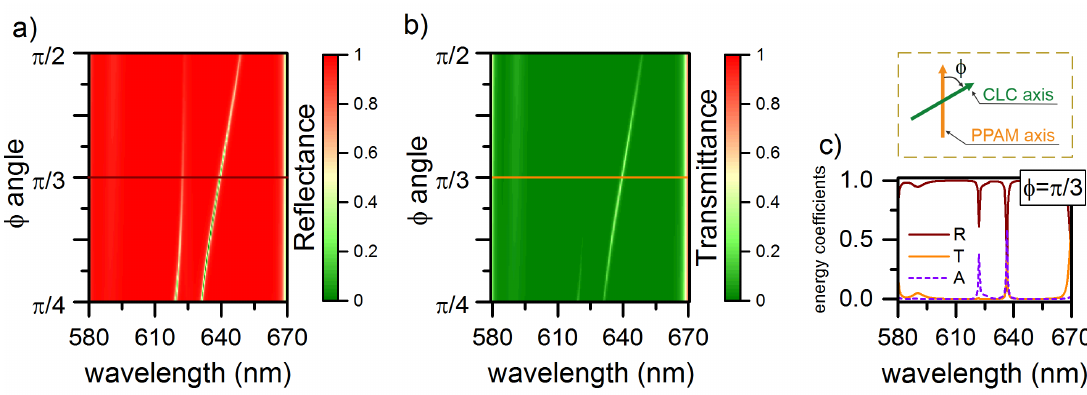
Figure 5. ( a ) Reflectance and ( b ) transmittance spectra of the structure at different angles ϕ . ( c ) Reflectance, transmittance, and absorptance spectra of the structure at ϕ = π /3. Insert: Definition of angle φ as the angle between the CLC director at the boundary and the optical axis of the PPAM layer conjugated with the CLC. The rest parameters are the same as in Figure